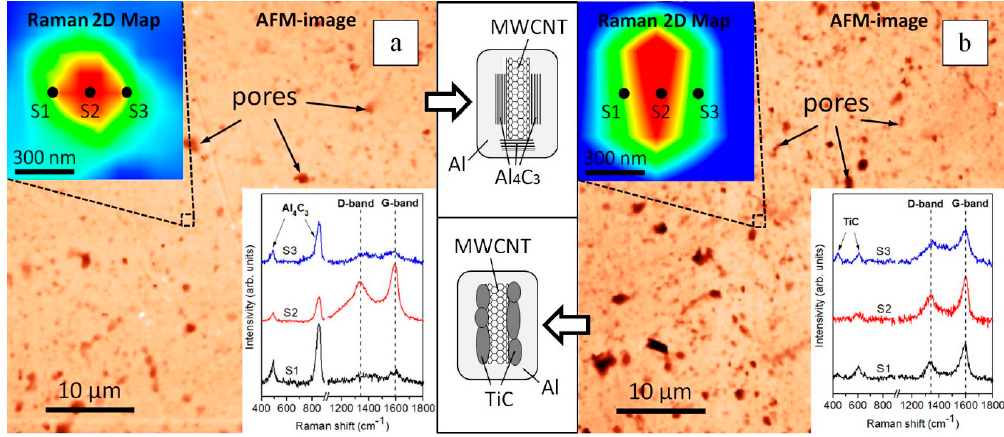
Figure 8. Atomic force microscopy (AFM) images of the surface, 2D mapping, and Raman spectra of the bulk composites: A_0.05CNT ( a ) and A_0.05TiC/CNT ( b ).